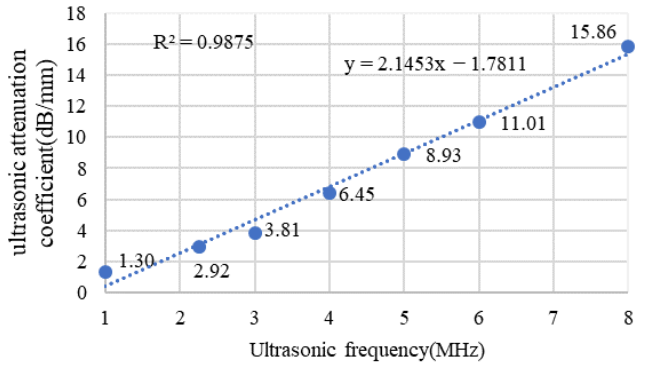
Figure 10. Relationship between the ultrasonic attenuation coefficient and the frequency of the Estane binder.